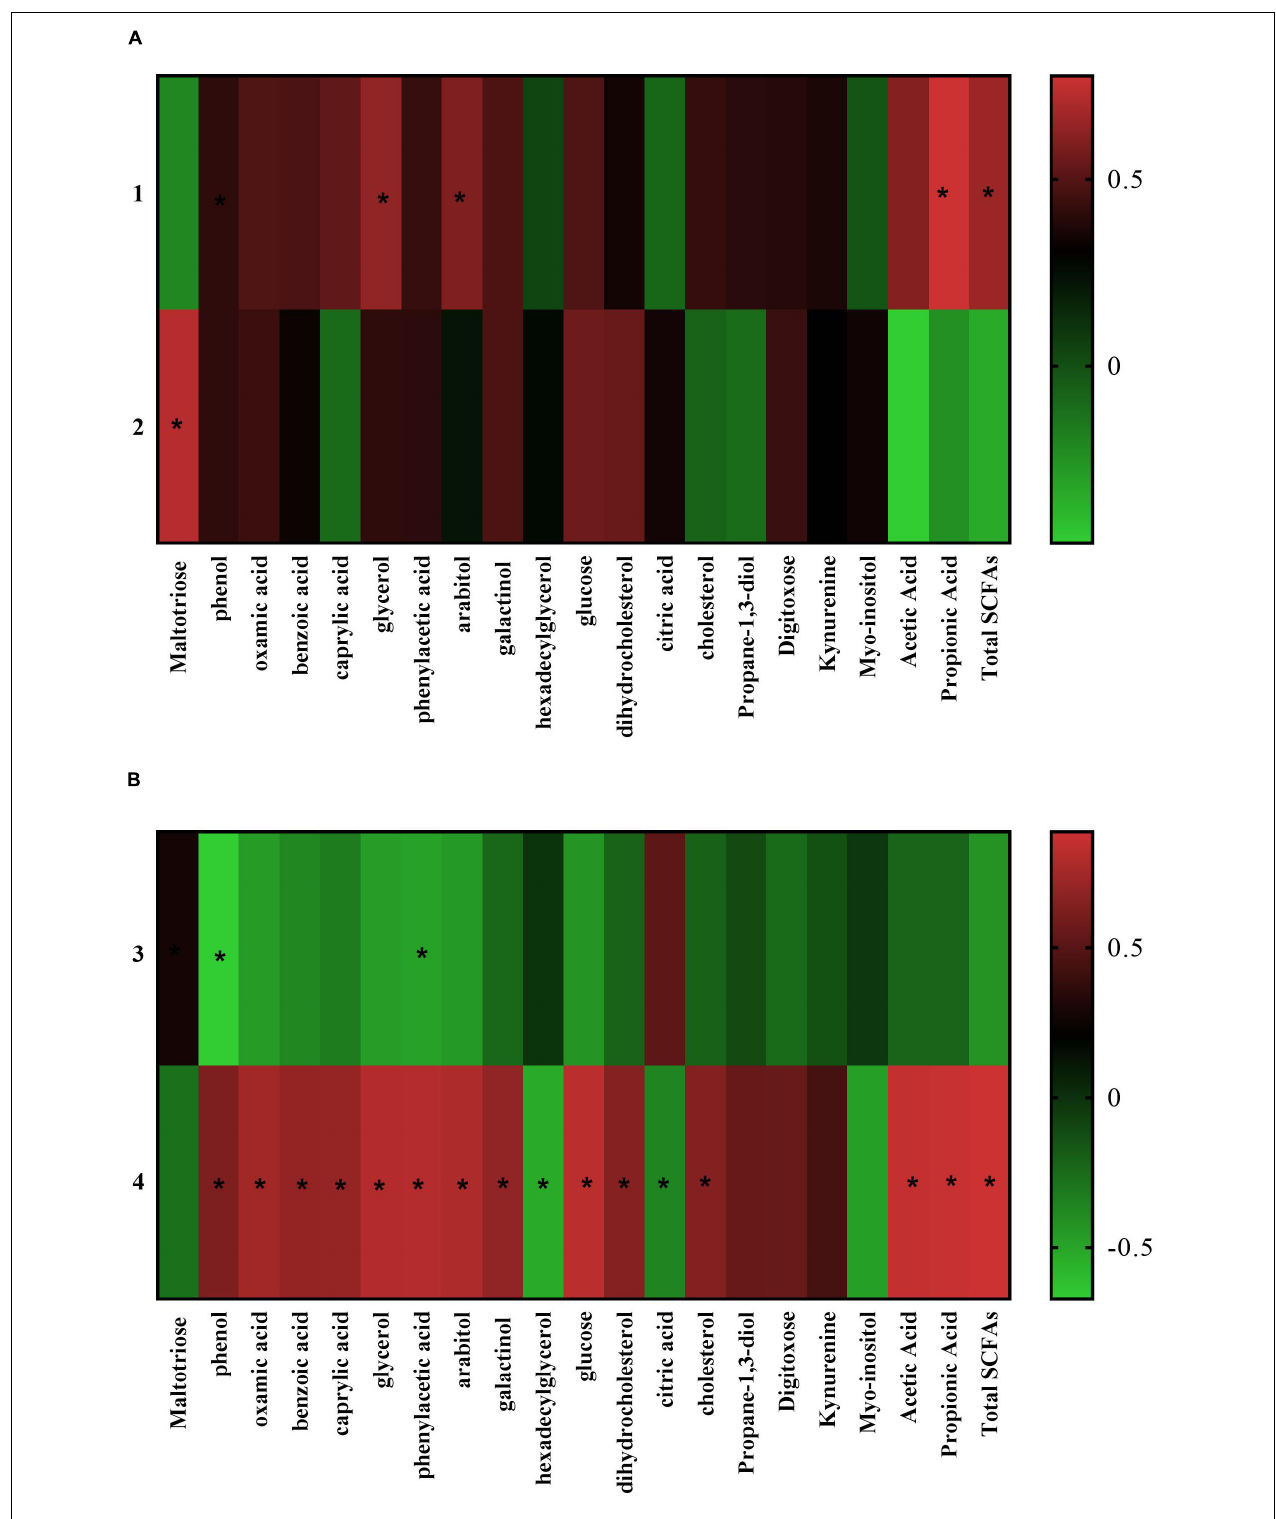
FIGURE 6 | Pearson correlation analysis between the different colonic microbiota and different metabolites (only metabolites with significant correlation are listed). (A) At the phylum level; (B) at the genus level. (1) Bacteroidetes ; (2) Lentisphaerae ; (3) Lactobacillus ; (4) Prevotellaceae_NK3B31_group . The cells are colored based on the Pearson correlation coefficient between the different bacteria (relative abundance) and metabolites (VIP > 1.0 and P < 0.05) in the colon, red represents positive correlation, green represents negative correlation, and * represents that the correlation was significant ( P < 0.05).